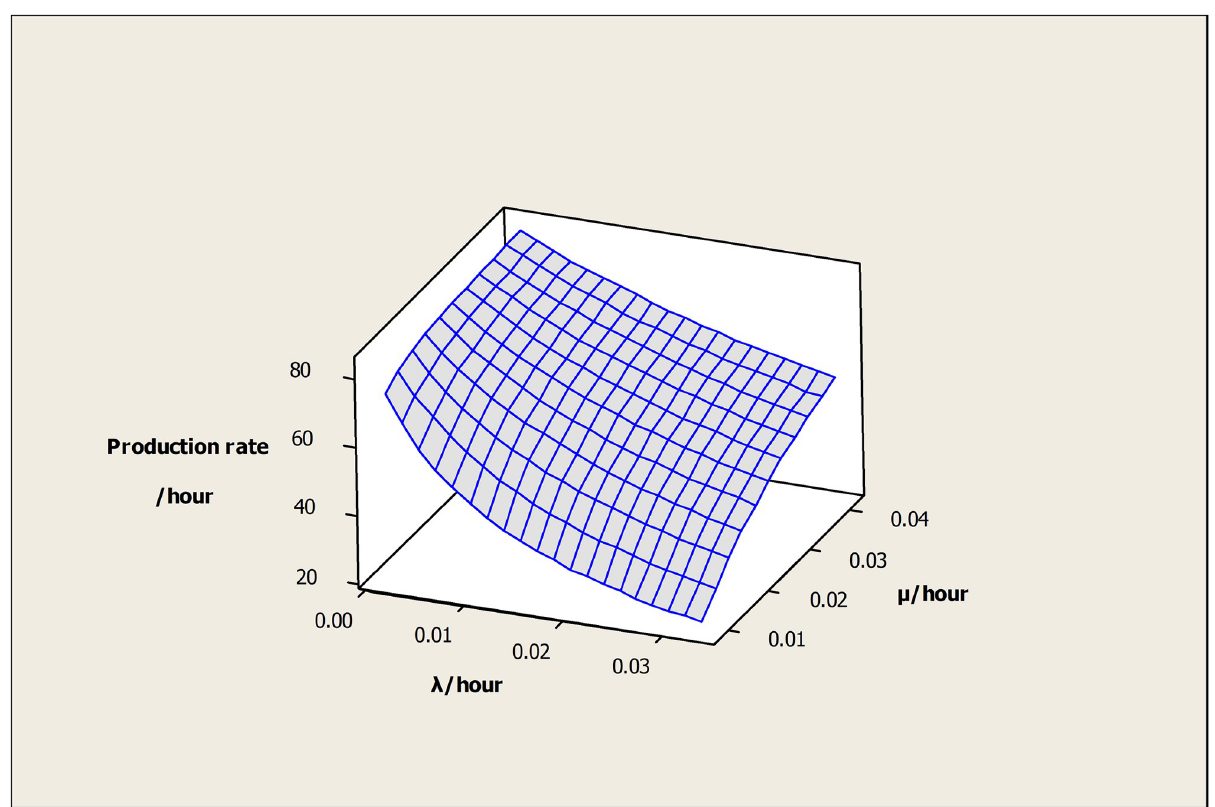
Fig 20. Surface plot of production rate/hour versus μ /hour, λ